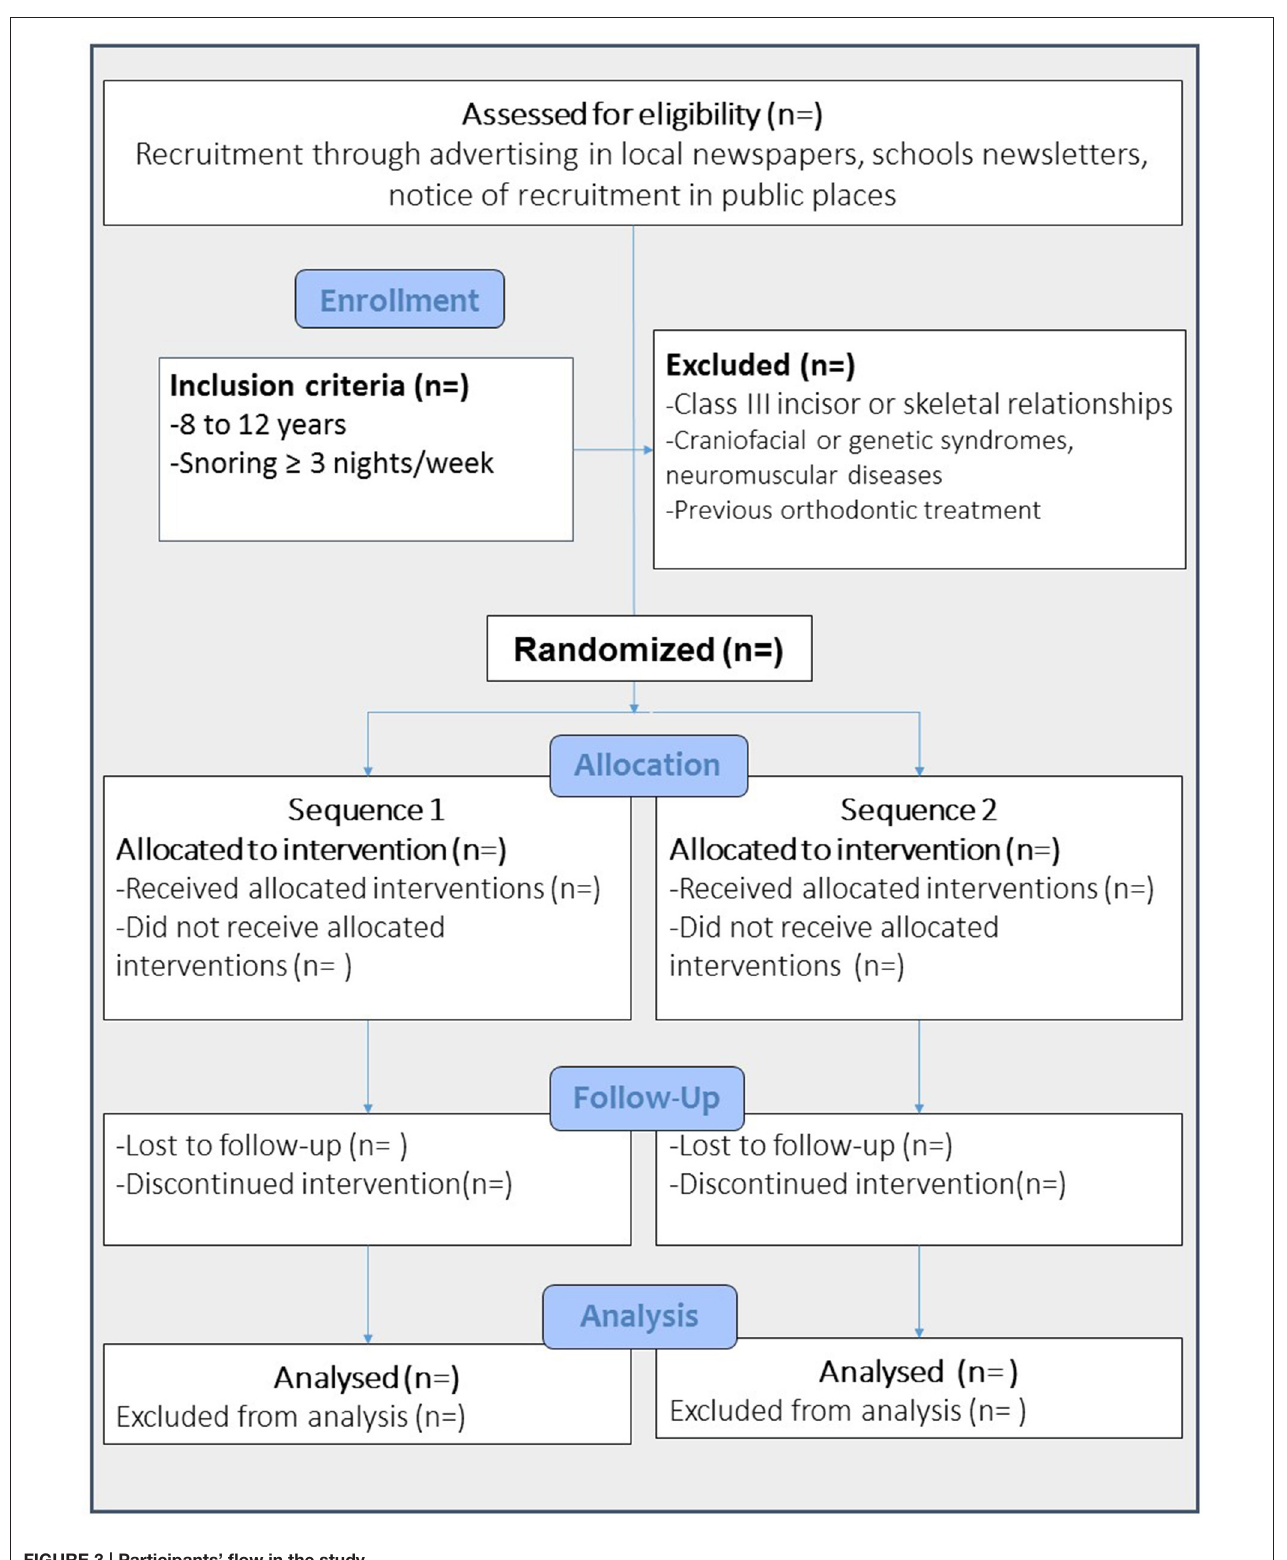
FIGURE 3 | Participants’ flow in the study.